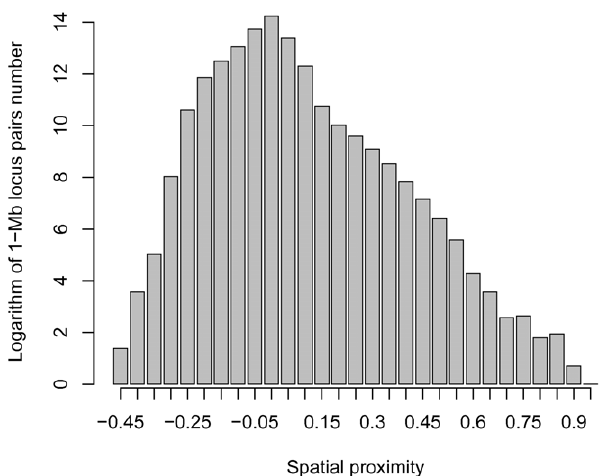
Figure 2. Histogram of the number of pairs of interacting genome fragments originating at different chromosomes in the human genome-wide spatial proximity matrix C .